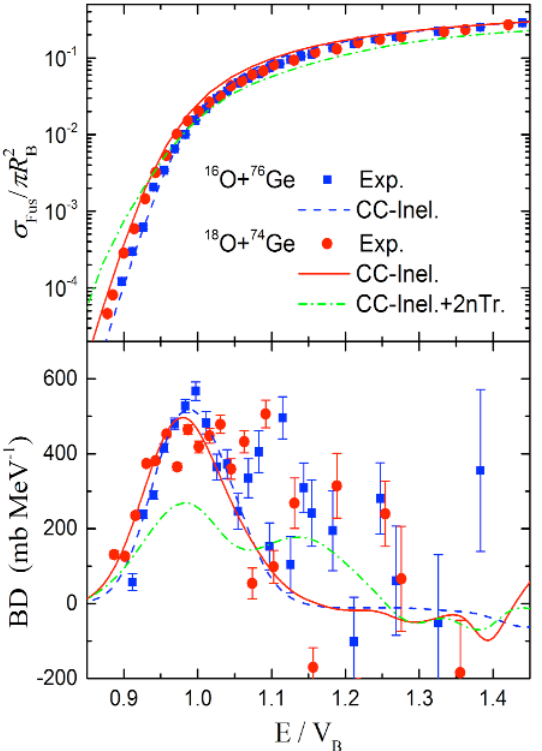
Figure 2. (Color online) Experimental reduced fusion excitation functions and barrier distributions compared with the coupled- channels calculations .